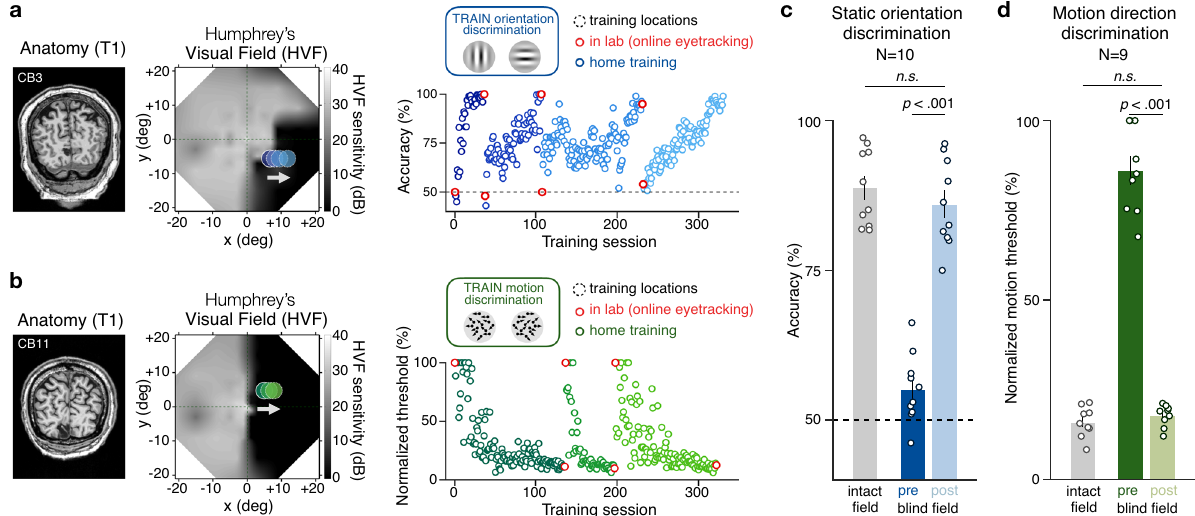
Fig. 1 Visual discrimination training recovers visual functions in chronic cortically-blind (CB) fi elds. a , b T1-weighted MRI and full (±21 deg) Humphrey Visual Field (HVF) for two chronic CB patients with stroke-induced damage to the primary visual cortex and associated loss of conscious luminance detection sensitivity. Dark regions (low HVF sensitivity) correspond to blind- fi eld areas. Visual training can successfully restore ( a ) static orientation discrimination and ( b ) coarse (left/right) global motion direction discrimination in the blind fi eld of chronic CB patients. Recovery is typically retinotopically-speci fi c, requires weeks of daily home training (blue/green dots in scatter plots), and can be veri fi ed in lab under eye-tracking control (red dots in scatter plots). As detailed in previous work 21 – 25 , all 11 CB patients included in the present study trained on ( c ) static orientation discrimination ( N = 10) and/or ( d ) motion direction discrimination ( N = 9) at different blind- fi eld locations. All CB patients recovered performance levels on these tasks similar to those at equivalent locations in their intact visual hemi fi elds. Bars show mean performance across subjects (±1 SEM), with individual data